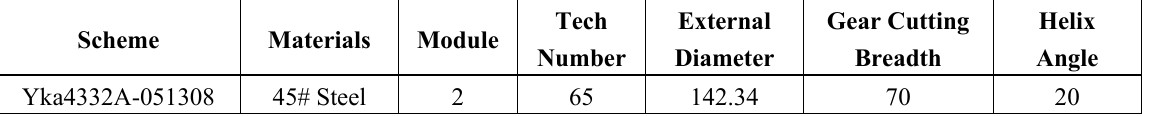
Table 8. Optimization result of process equipment and parameters for the hobbing procedure.